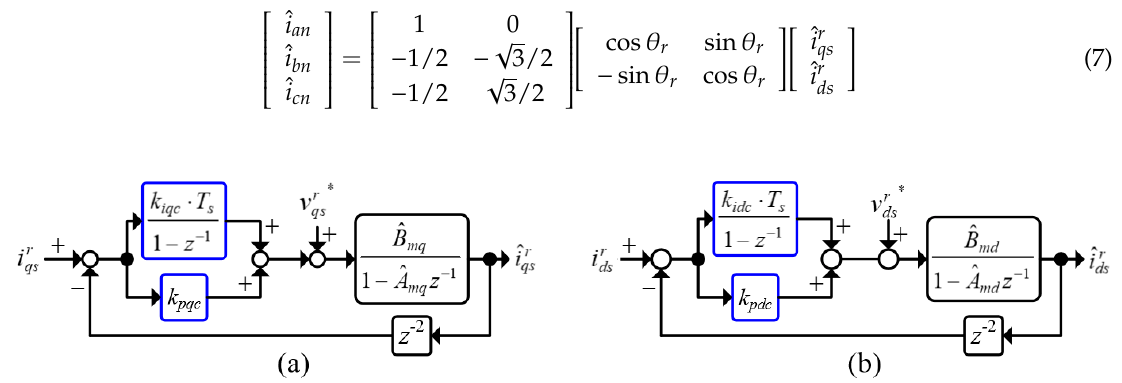
Figure 4. The proposed ( a ) q -axis and ( b ) d -axis current estimator.